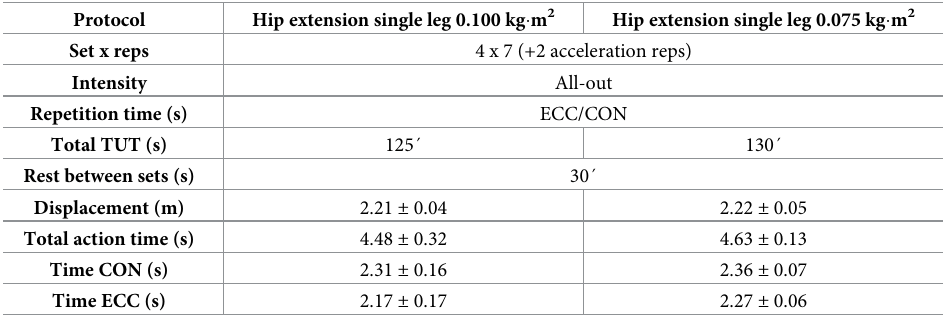
Table 2. Training protocols. Data: mean ±